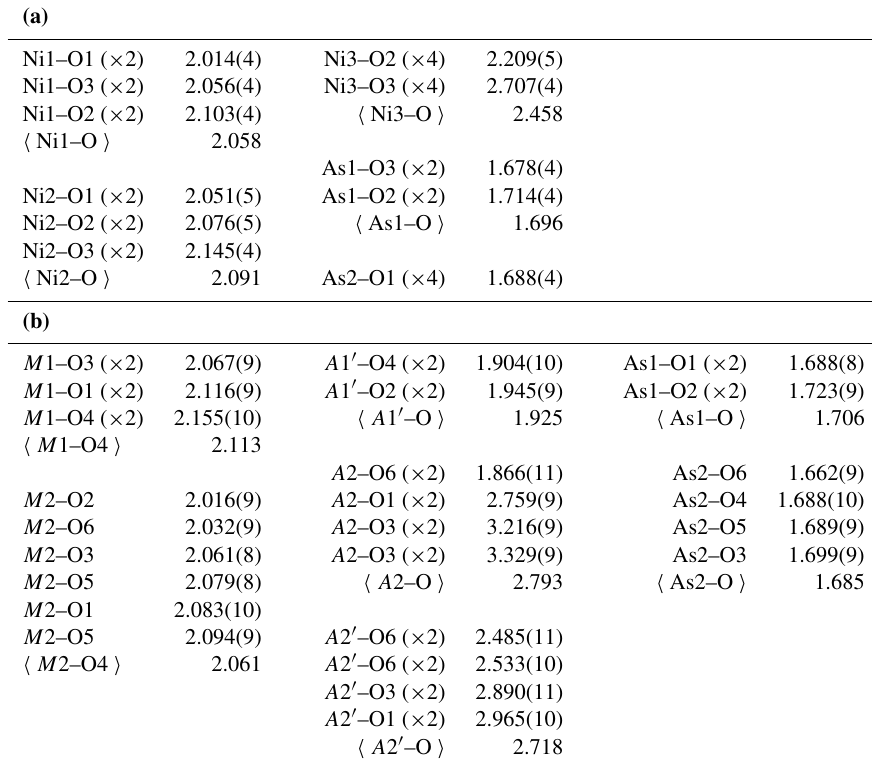
Table 5. (a) Selected bond distances (Å) for niasite. (b) Selected bond distances (Å) for johanngeorgenstadtite.